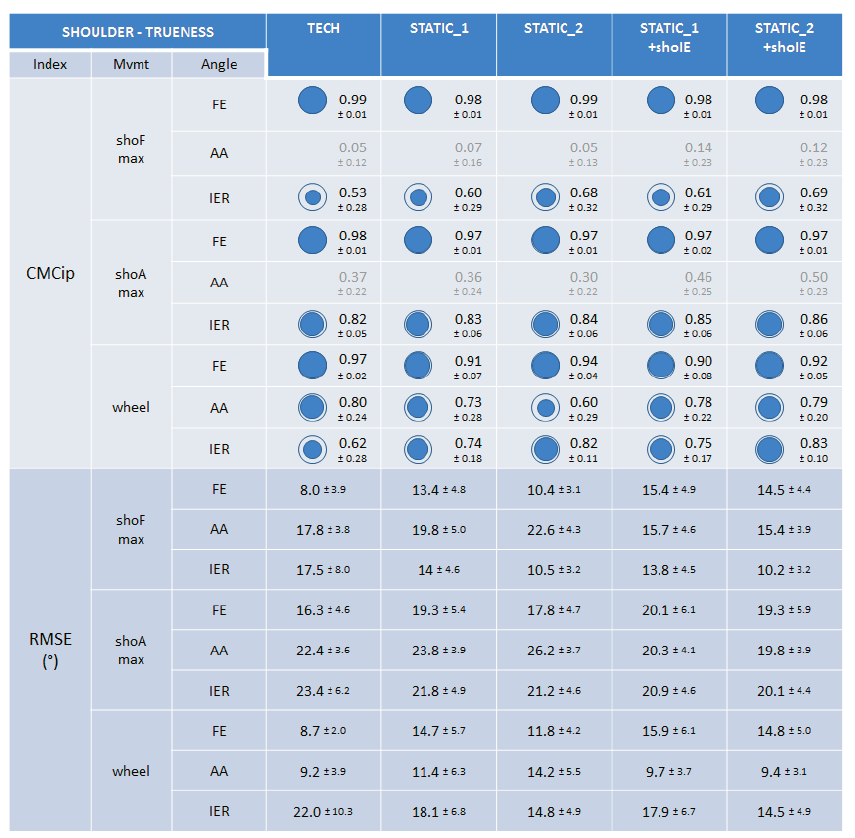
Figure 9. The results on trueness for the shoulder joint. CMCip and RMSE values are reported for the different calibrations during the maximal shoulder flexion (shoFmax), maximal shoulder abduction in the scapular plane (shoAmax), and wheel movements. For visual clarity, the CMCip value is completed with a proportional blue disc included in a blue circle that represents the optimal value